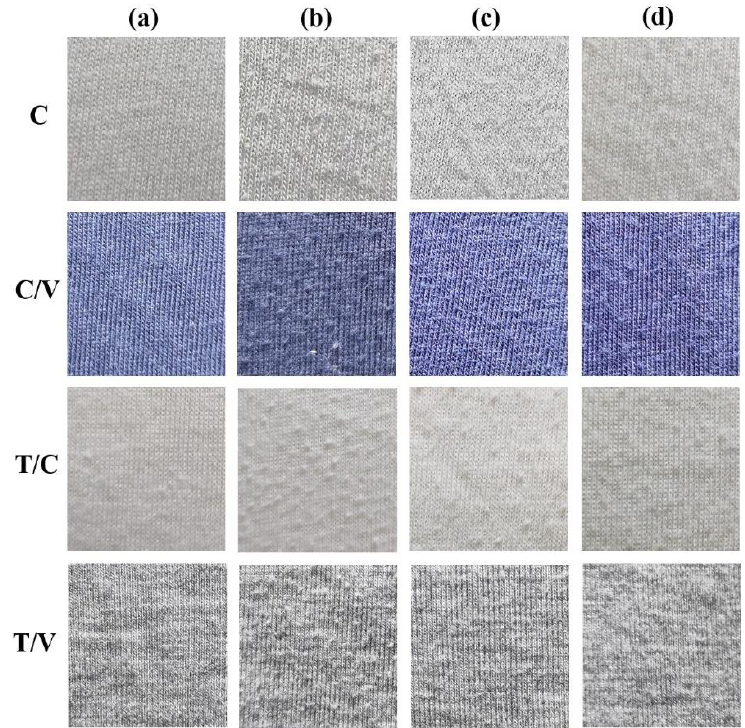
Figure 4. Digital camera images of original samples and pilling samples after 2000 rubs. ( a ) Original samples; ( b ) control samples; ( c ) treated with the dipping process; ( d ) treated with the pad–dry–cure